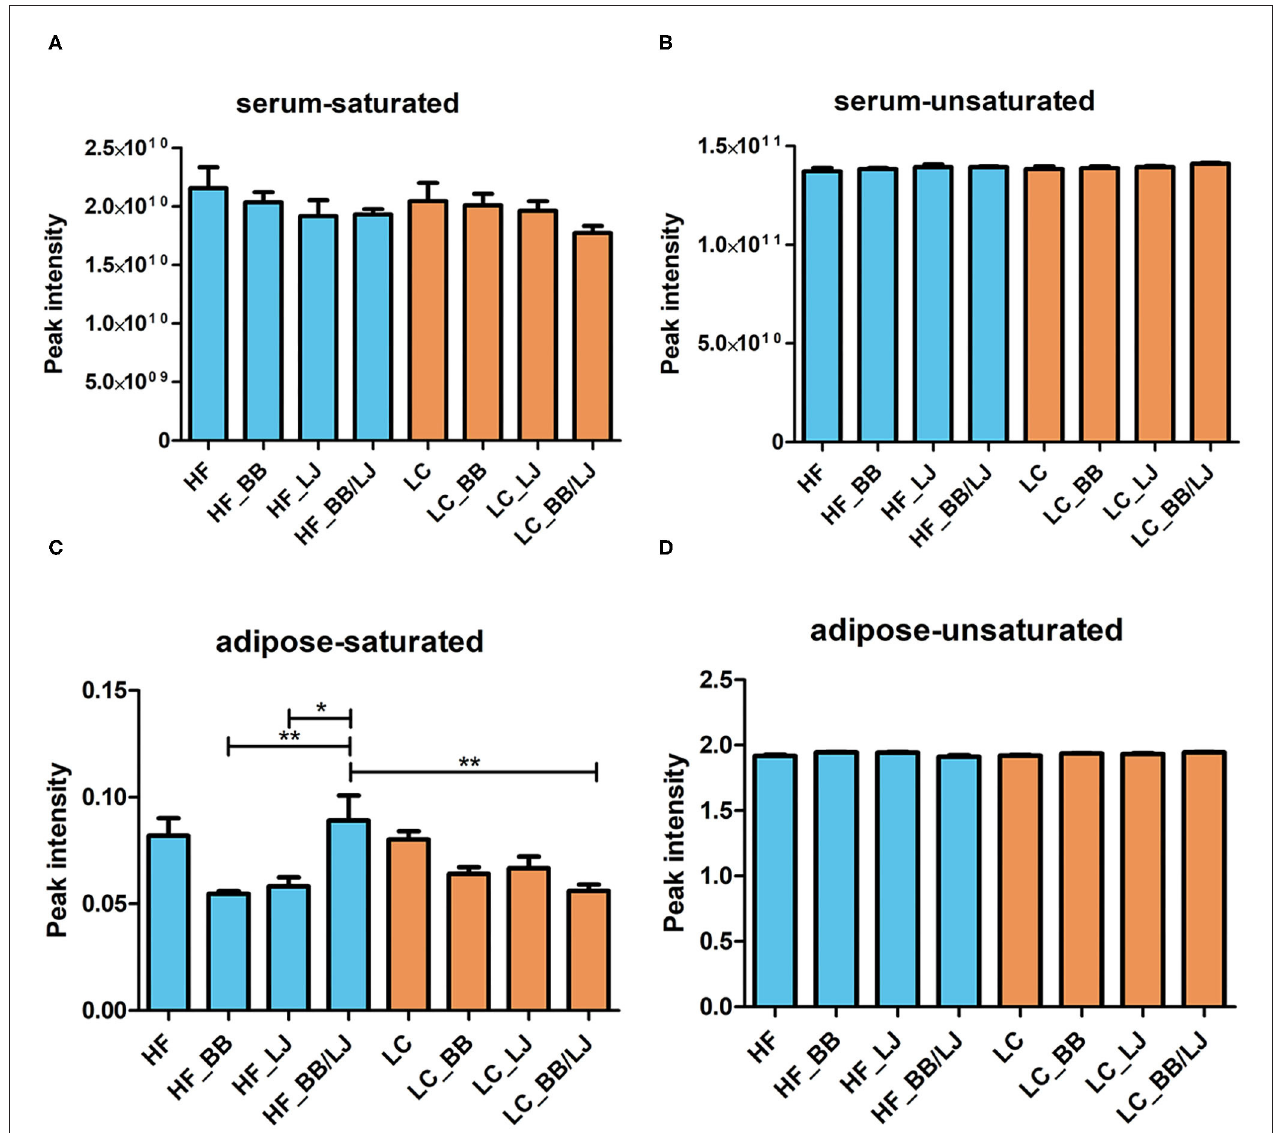
FIGURE 5 | Average concentration of (A) saturated lipids and (B) unsaturated lipids on serum of the animals, as well as (C) saturated lipids and (D) unsaturated lipids on adipose tissue in the same animals. HF, high-fat diet; LC, low-calorie diet; BB, blueberry extract; LJ, L. johnsonii N6.2; BB/LJ, blueberry extract + L. johnsonii N6.2. Blue bars: animals under HF diet; orange bars: animals under LC diet. Data are summarized as mean and ± standard deviation. * p -value < 0.05; ** p -value <